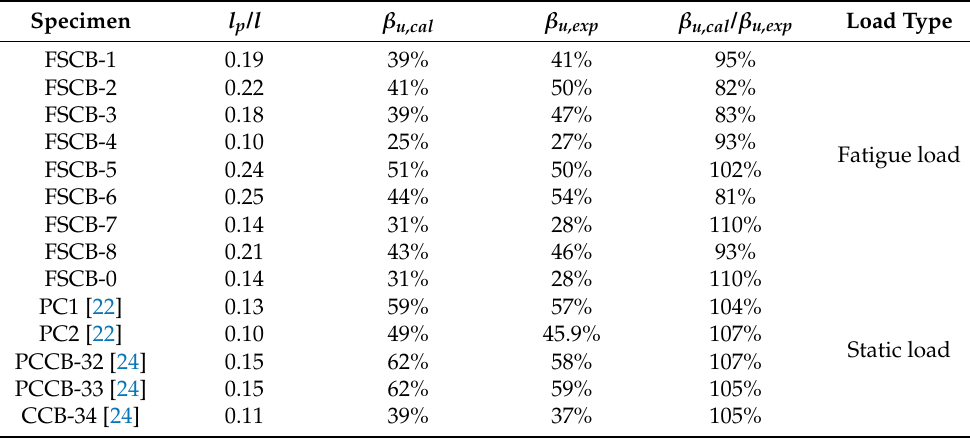
Table 8. Calculated and experimental values of moment modification